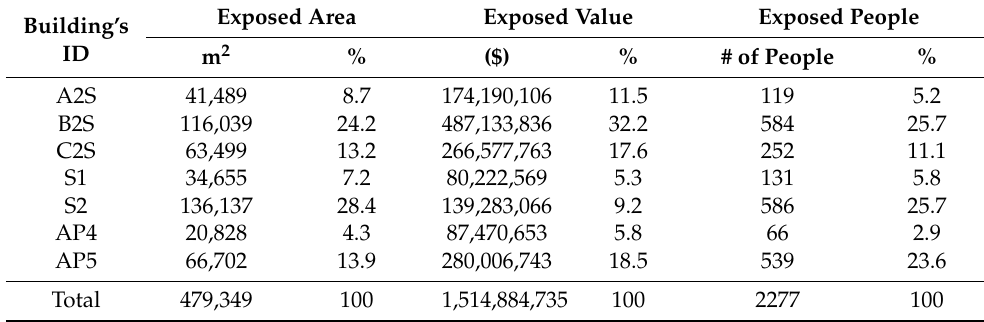
Table 3. Exposed area, exposed value, and exposed people per building category.